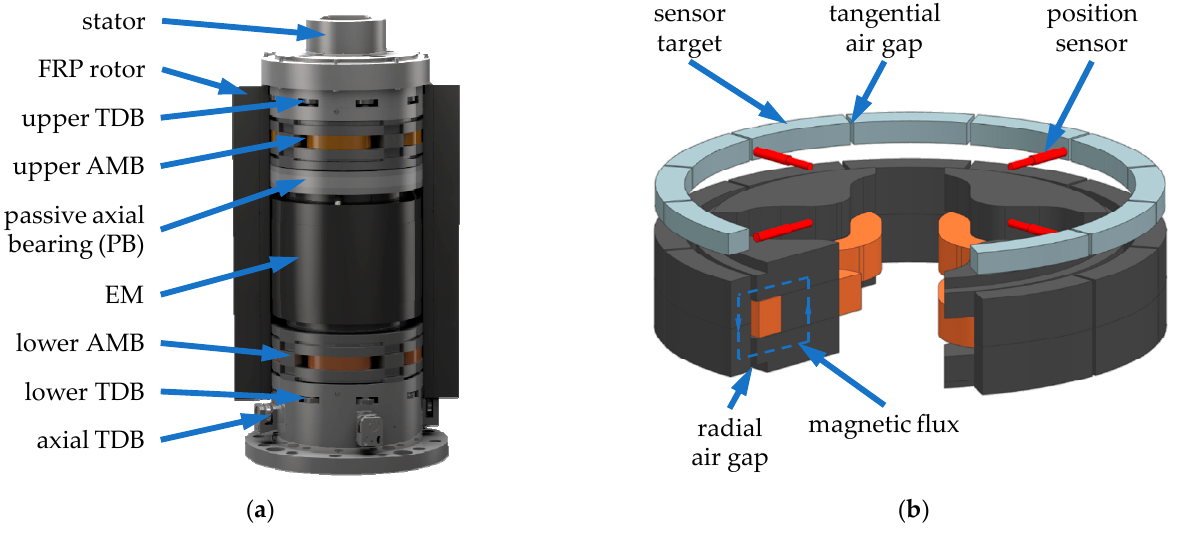
Figure 1. ( a ) Partial section view of the ETA-290 without the containment; ( b ) radial AMB with sensor plane and air gaps [2].